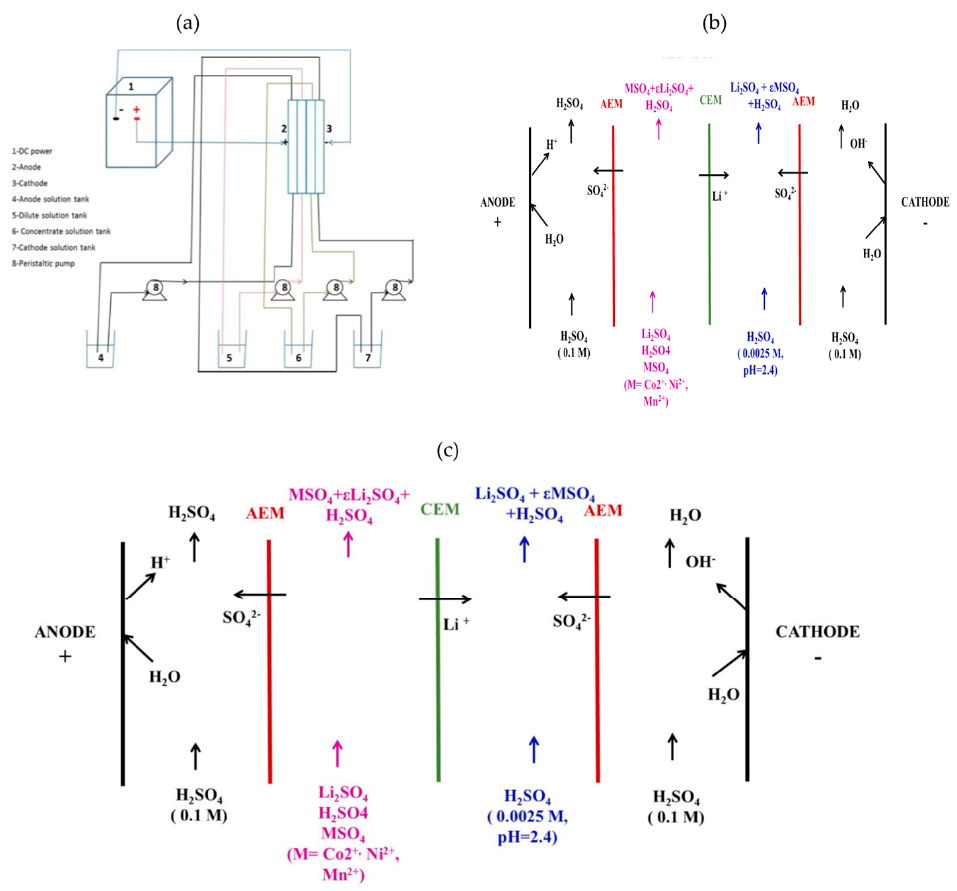
Figure 1. ( a ) ED setup; ( b ) Configuration 1 of the electrodialysis cell and ( c ) Configuration 2 of the electrodialysis cell.